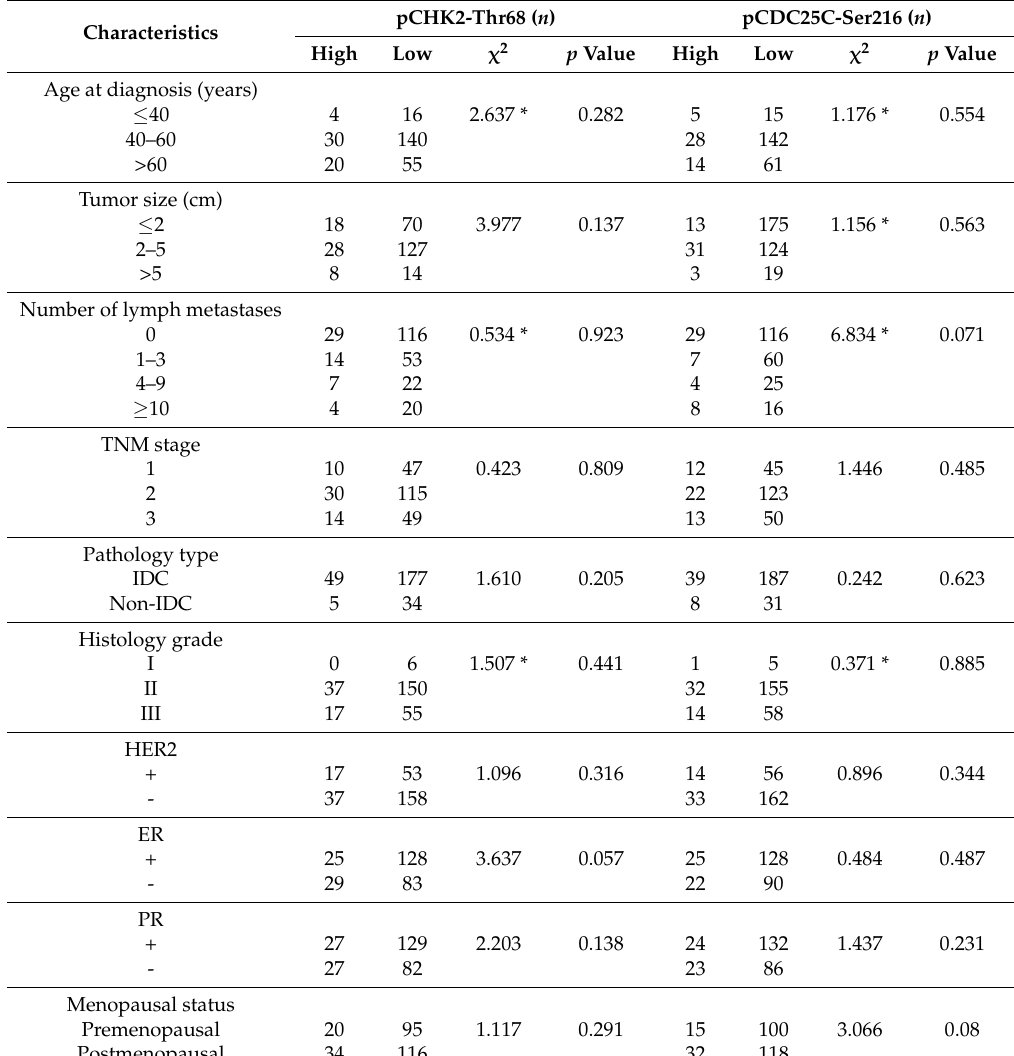
Correlation between high/low (referring number of cases) pCHK2-Thr68 and pCDC25C-Ser216 expression and clinicopathological factors in 265 breast cancer tumor tissues.